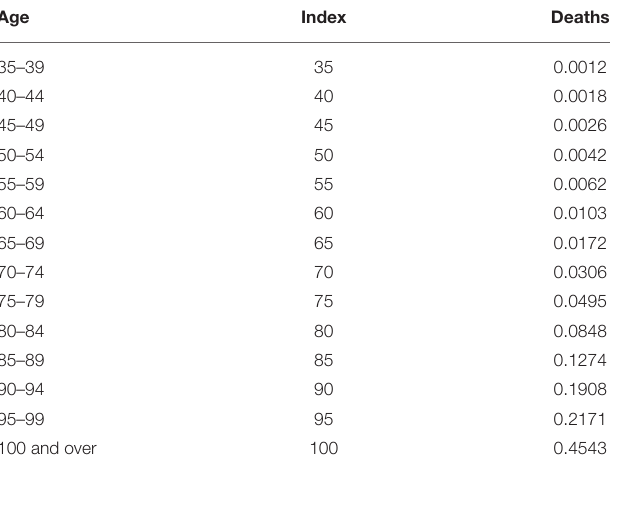
TABLE 5 | Natural mortality among people over 35 years of age in China.